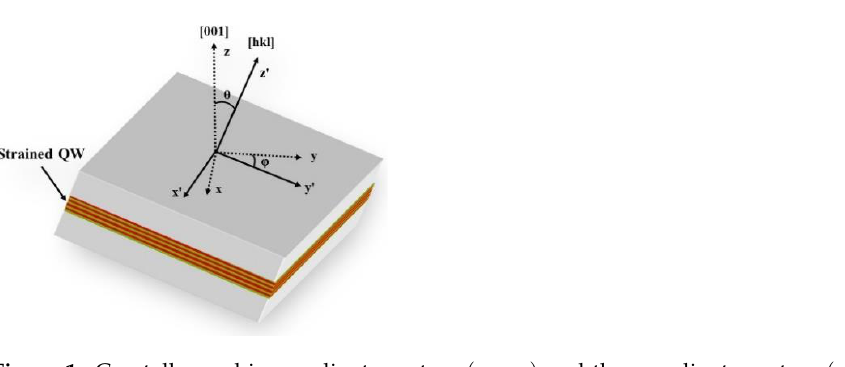
Figure 1. Crystallographic coordinate system ( x , y , z ) and the coordinate system ( x (cid:48) , y (cid:48) , z (cid:48) ) for a (hkl)-oriented strained